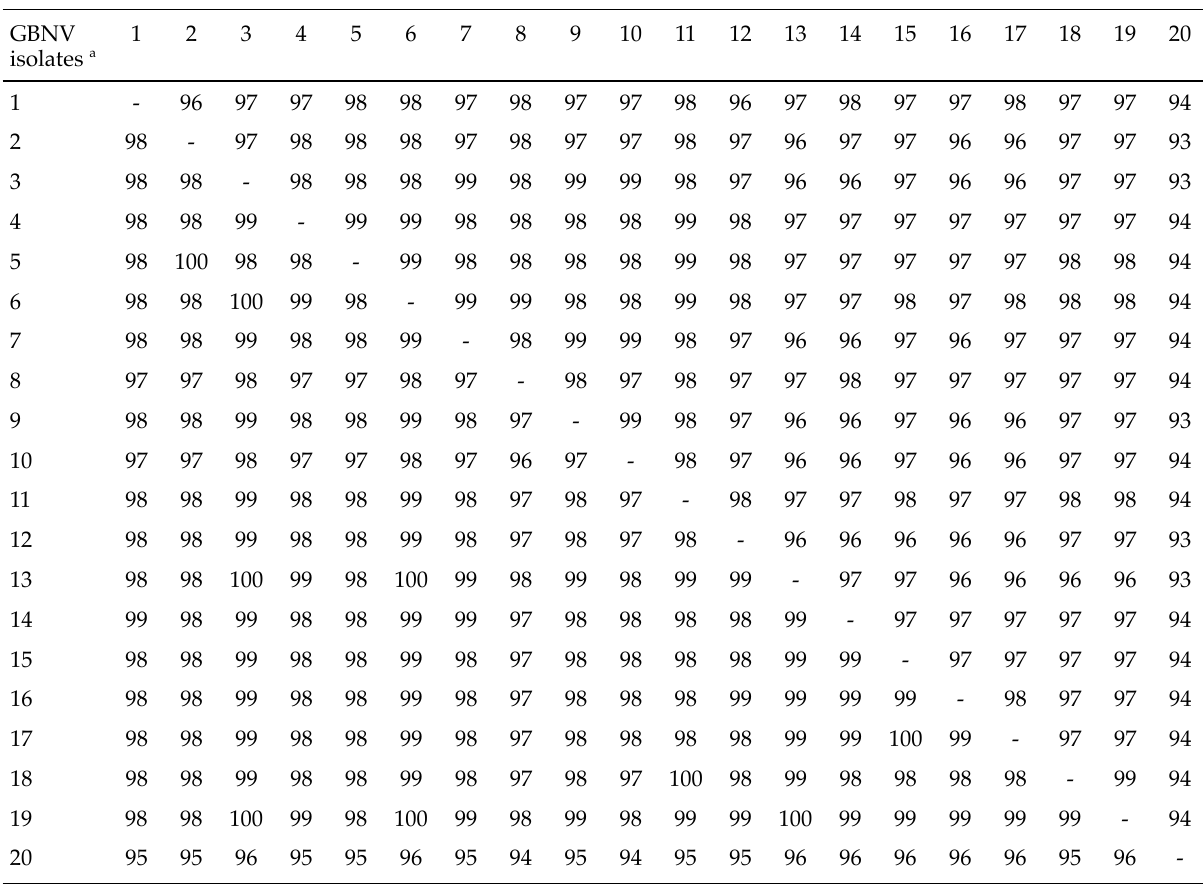
Table 3. Similarity of the NP gene sequences of GBNV isolates (above diagonal, nucleotide similarity; below diagonal, amino acid